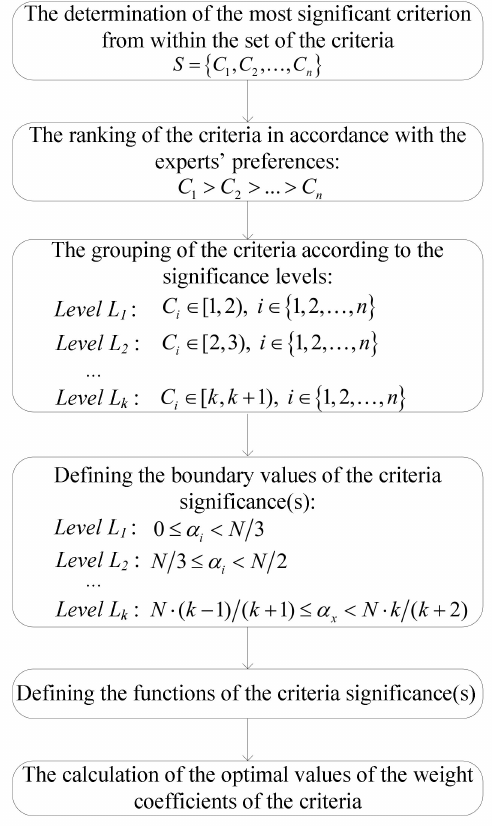
Figure 1. The non-decreasing series at criteria significance levels (NDSL)